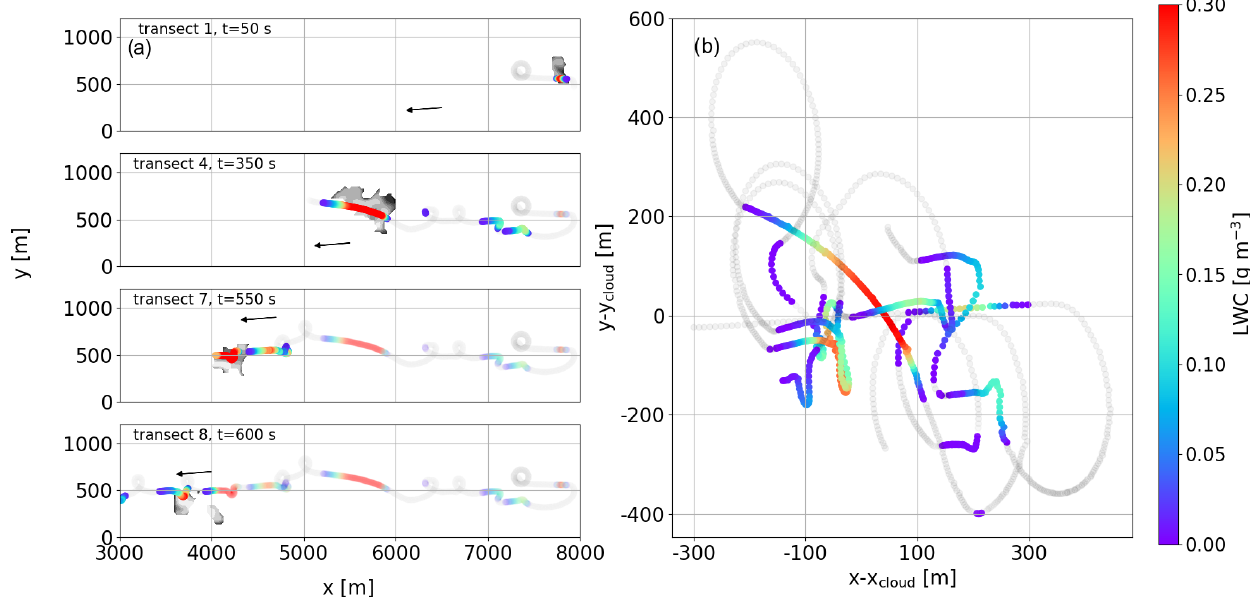
Figure 14. (a) Trajectories of exploration by following cloud N2 for four different transects. The colors represent the measured LWC, and the gray surface corresponds to the cross section of reference cloud N2 for the different times. The shading colors correspond to the past transects. The black arrow represents the direction of the advective wind. (b) Measured LWC in cloud frame during the exploration. The colored lines correspond to the values of measured LWC exceeding 10 − 2 gm − 3 , and the gray lines correspond to the measured LWC below this threshold.